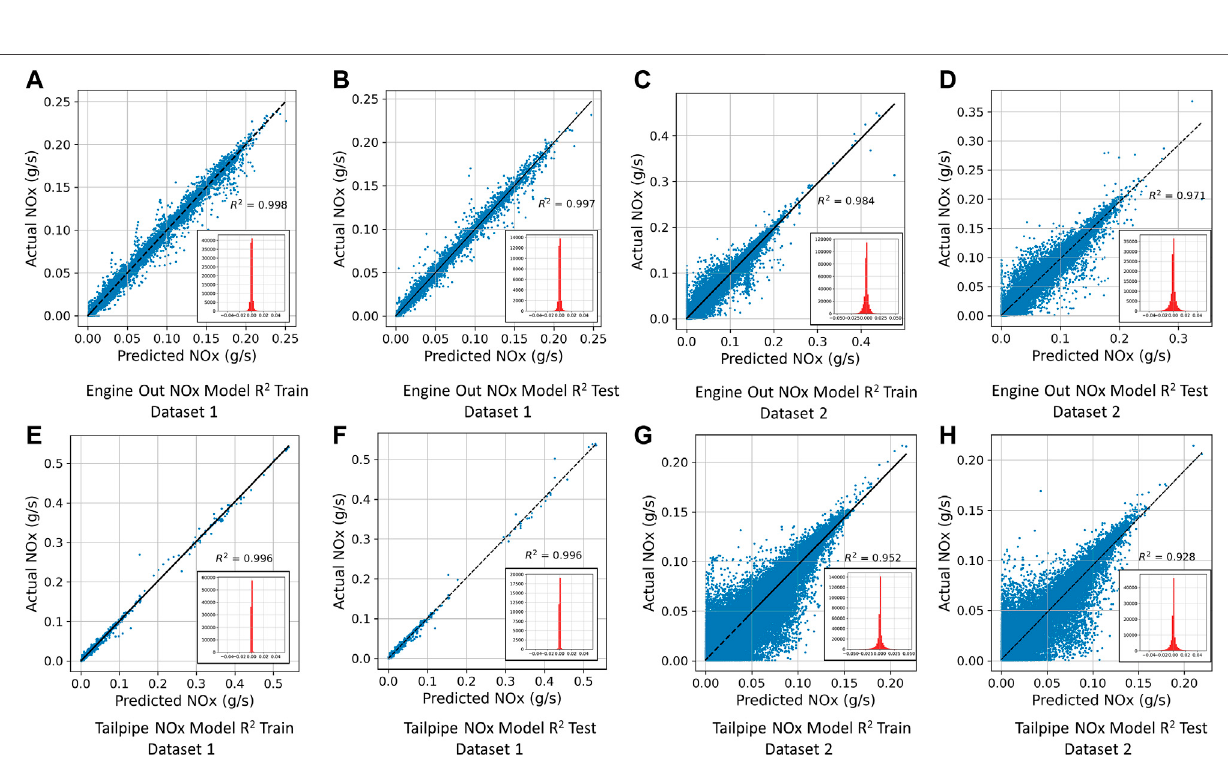
FIGURE 4 | Train and Test R 2 fi ts with histograms showing distribution of errors (All Models). (A) : Engine Out NOx Model R 2 Train Dataset 1. (B) : Engine Out NOx Model R 2 Test Dataset 1. (C) : Engine Out NOx Model R 2 Train Dataset 2. (D) : Engine Out NOx Model R 2 Test Dataset 2. (E) : Tailpipe NOxModel R 2 Train Dataset 1. (F) : Tailpipe NOx Model R 2 Test Dataset 1. (G) : Tailpipe NOx Model R 2 Train Dataset 2. (H) : Tailpipe NOx Model R 2 Test Dataset